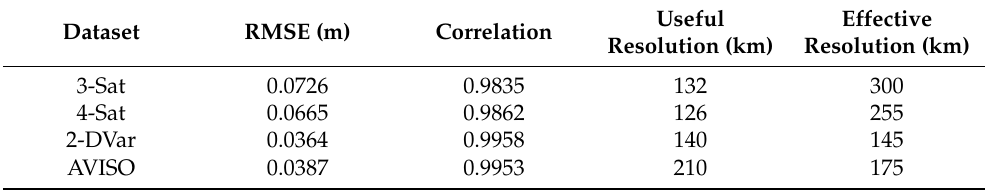
Table 1. RMSE, correlation, useful resolution and effective resolution of all the datasets.